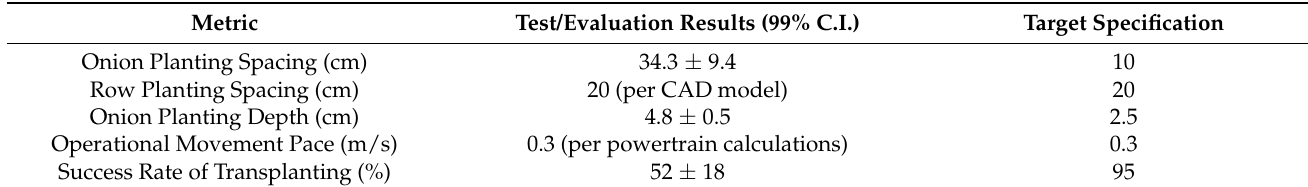
Table 8. Performance compared to transplanter’s target